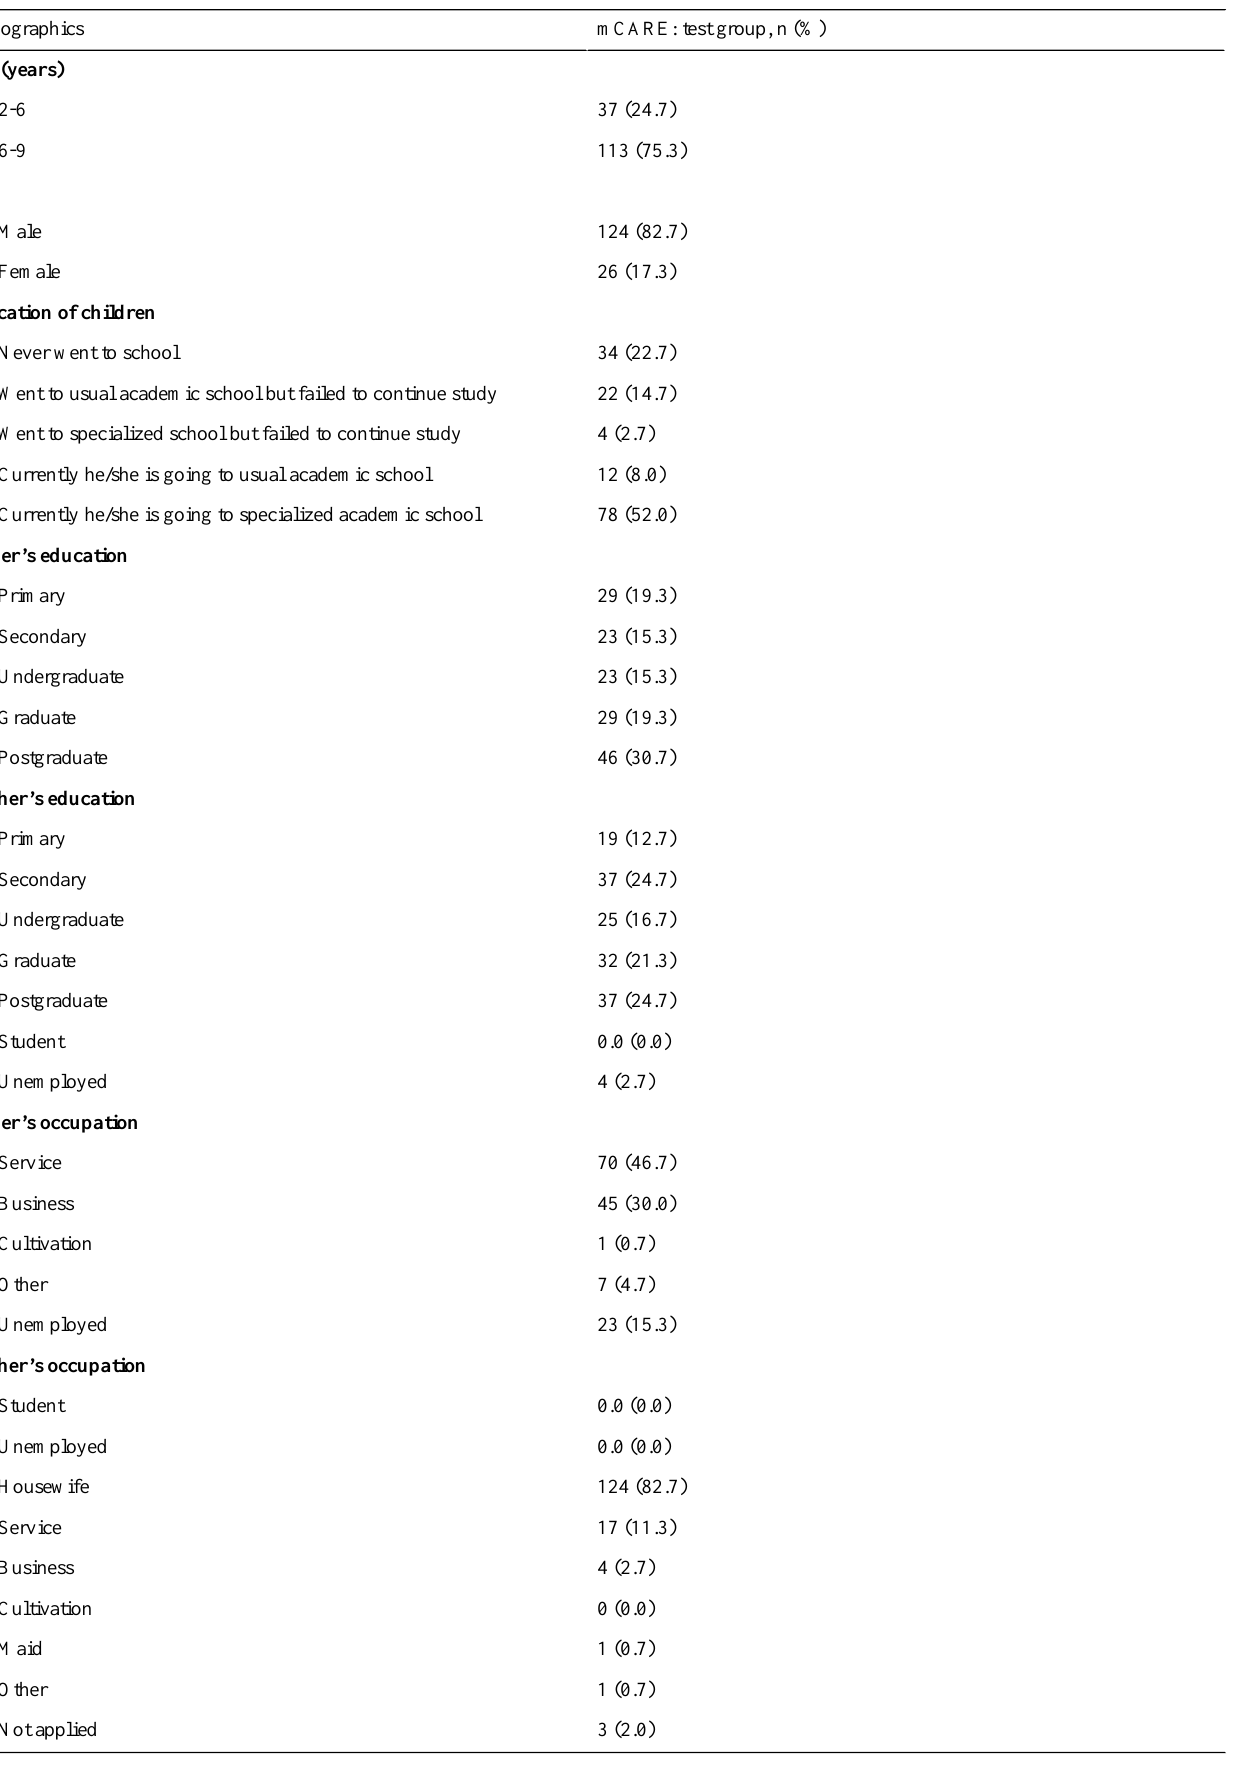
Table 2. Demographic information of participants in the test group